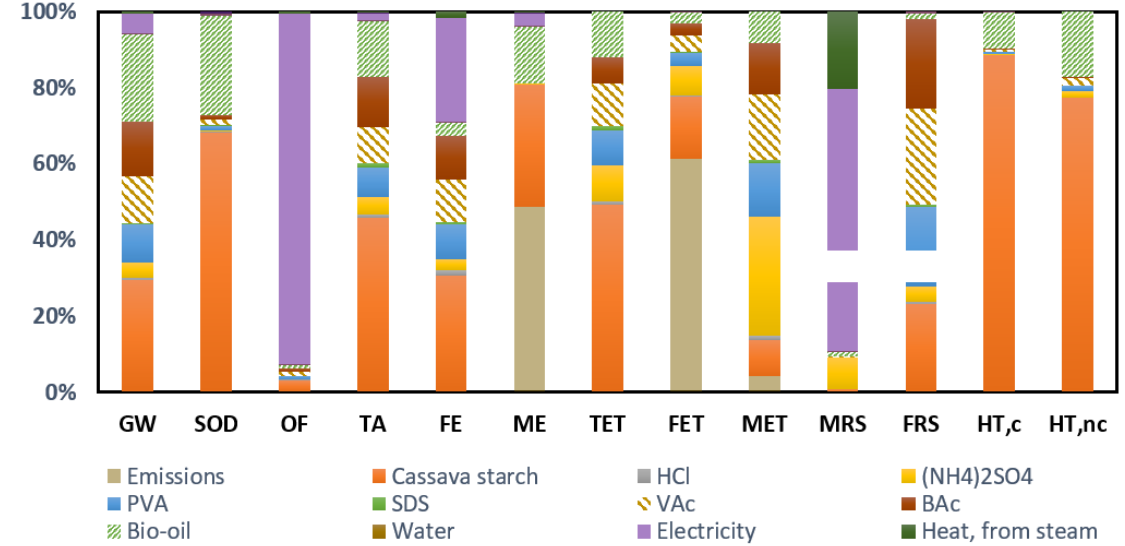
Figure 2. Environmental profile of the hydrolyzed starch bioadhesive with bio-oil (Alternative 1).